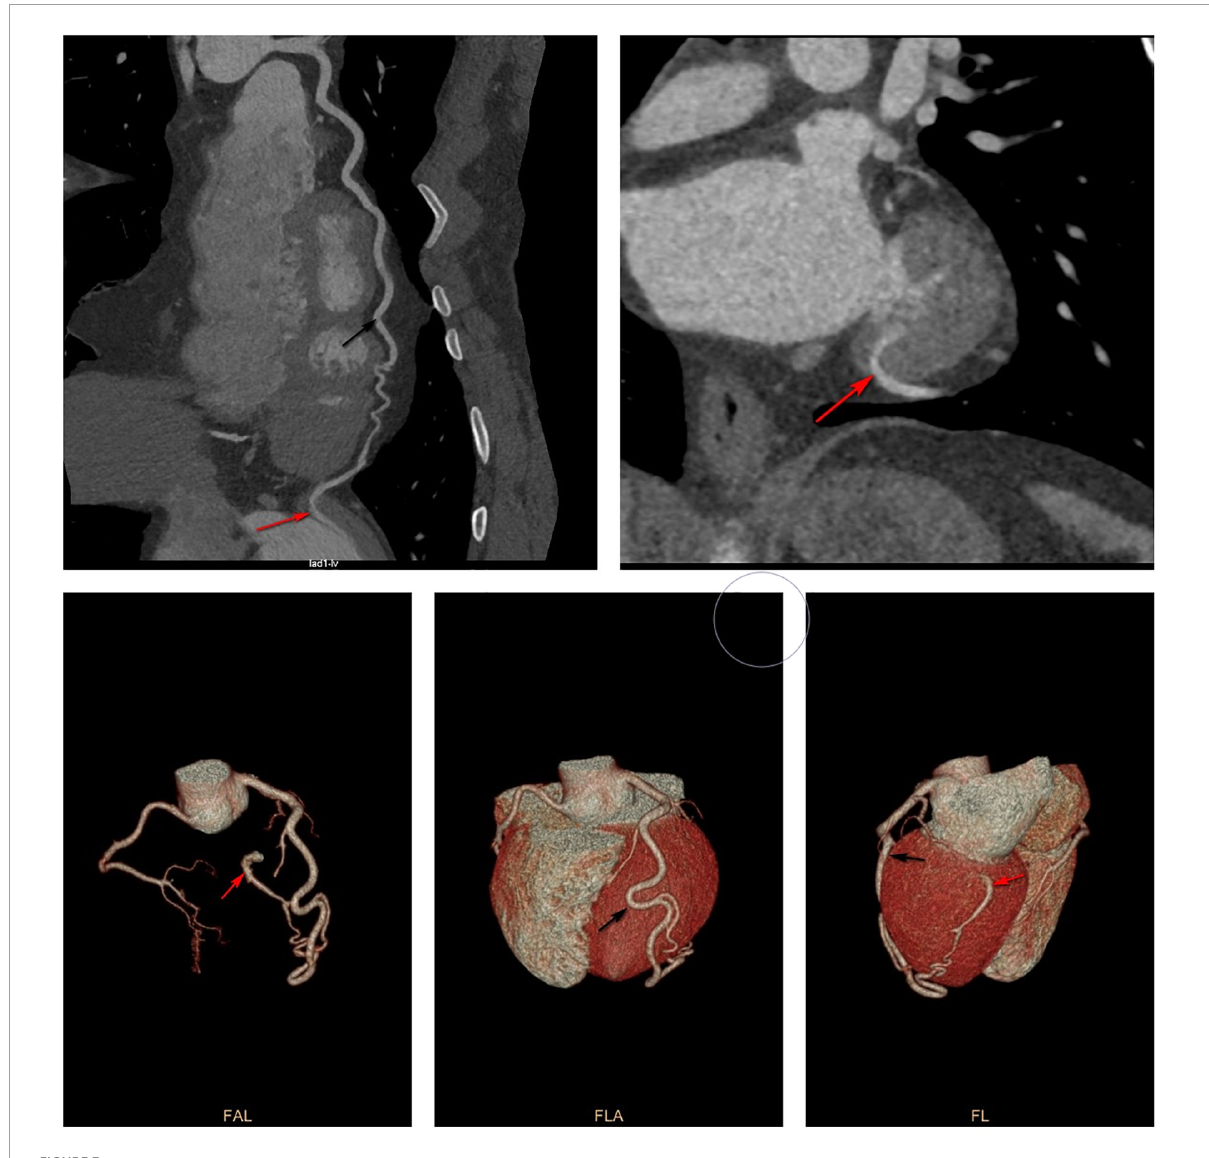
FIGURE3 Computed tomography angiography showed that the diagonal branch of the left coronary artery was twisted, lengthened, expanded, extended along the left heart margin, and its distal end penetrated the myocardium from the basal segment of the left ventricular posterior edge into the left ventricle. Black arrow shows the thick diagonal branch; red arrow shows coronary artery-left ventricular